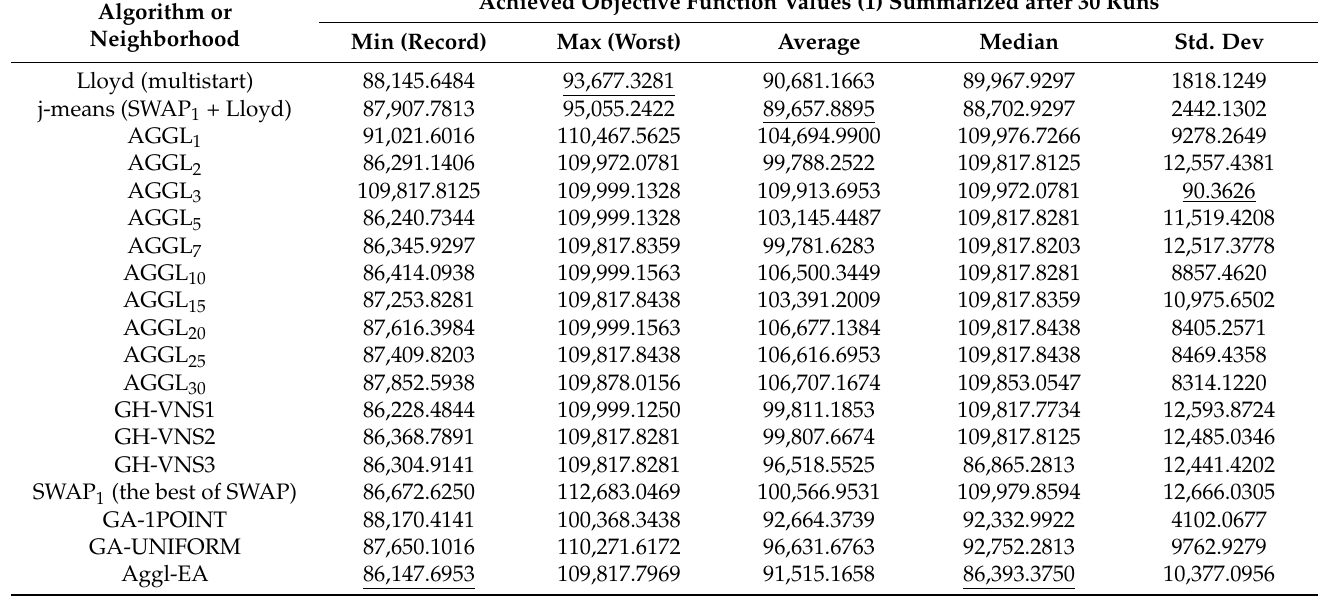
Table A11. Comparative results for Individual Household Electric Power Consumption (IHEPC) dataset. 2,075,259 data vectors in R 7 , p = 30 centers, time limitation 5 min.